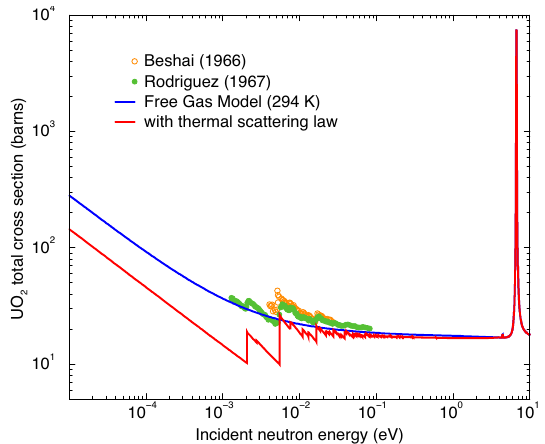
Fig. 9. Comparison of the experimental and theoretical total cross section of UO 2 at room temperature.